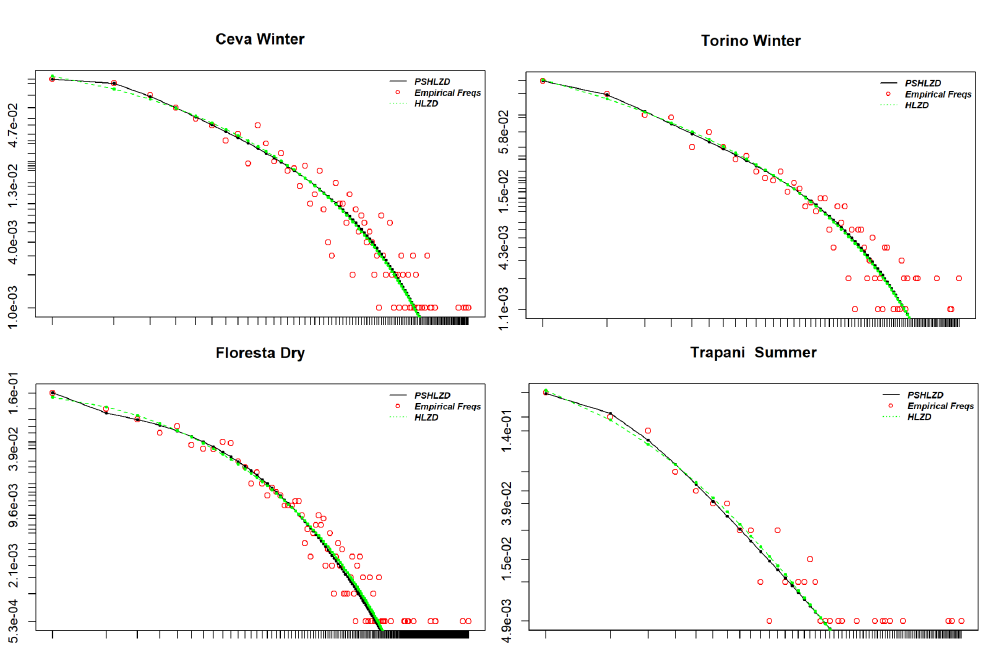
Figure 6. Log-log plots of the fitted HLZD (green dotted line), the fitted PSHLZD (black solid line) and the h empirical frequencies (red dot line) for the 4 selected samples Ceva Winter , Torino Winter , Floresta Dry and Trapani Summer